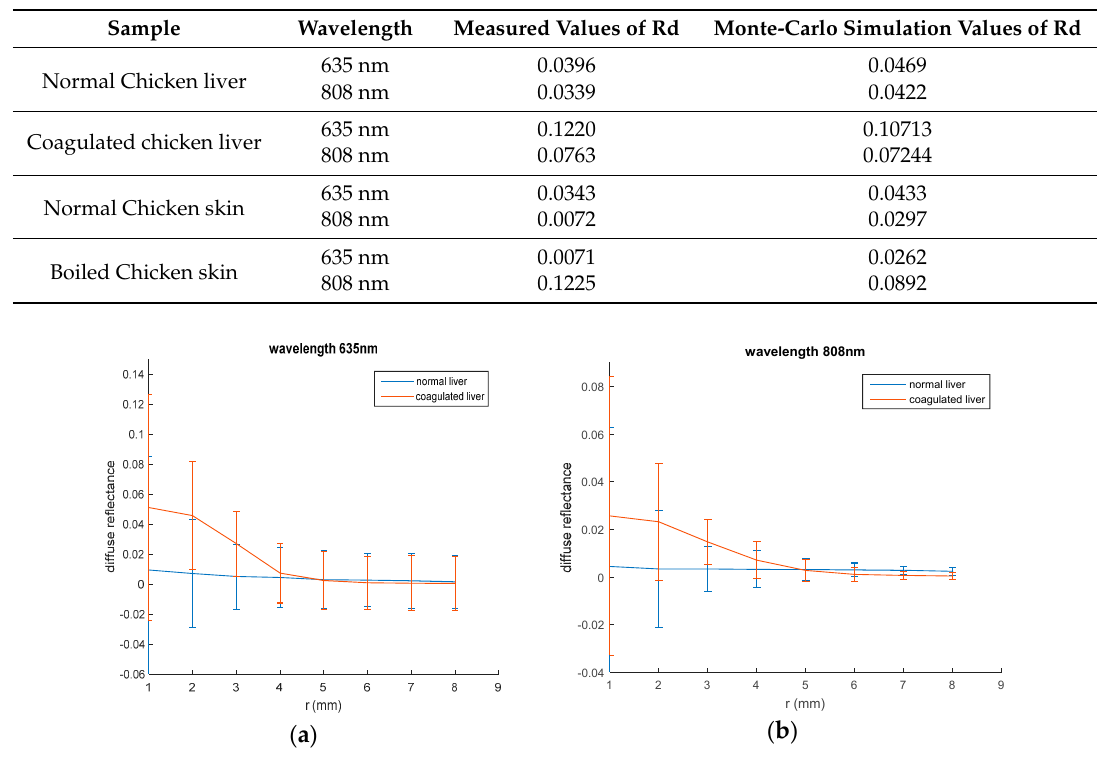
Figure 4. Spatially resolved steady state diffuse reflectance of normal and coagulated chicken liver: ( a ) at 635 nm; ( b ) at 808 nm laser irradiation. Diffuse reflectance curves in normal and boiled skin samples are illustrated in Figure 5.